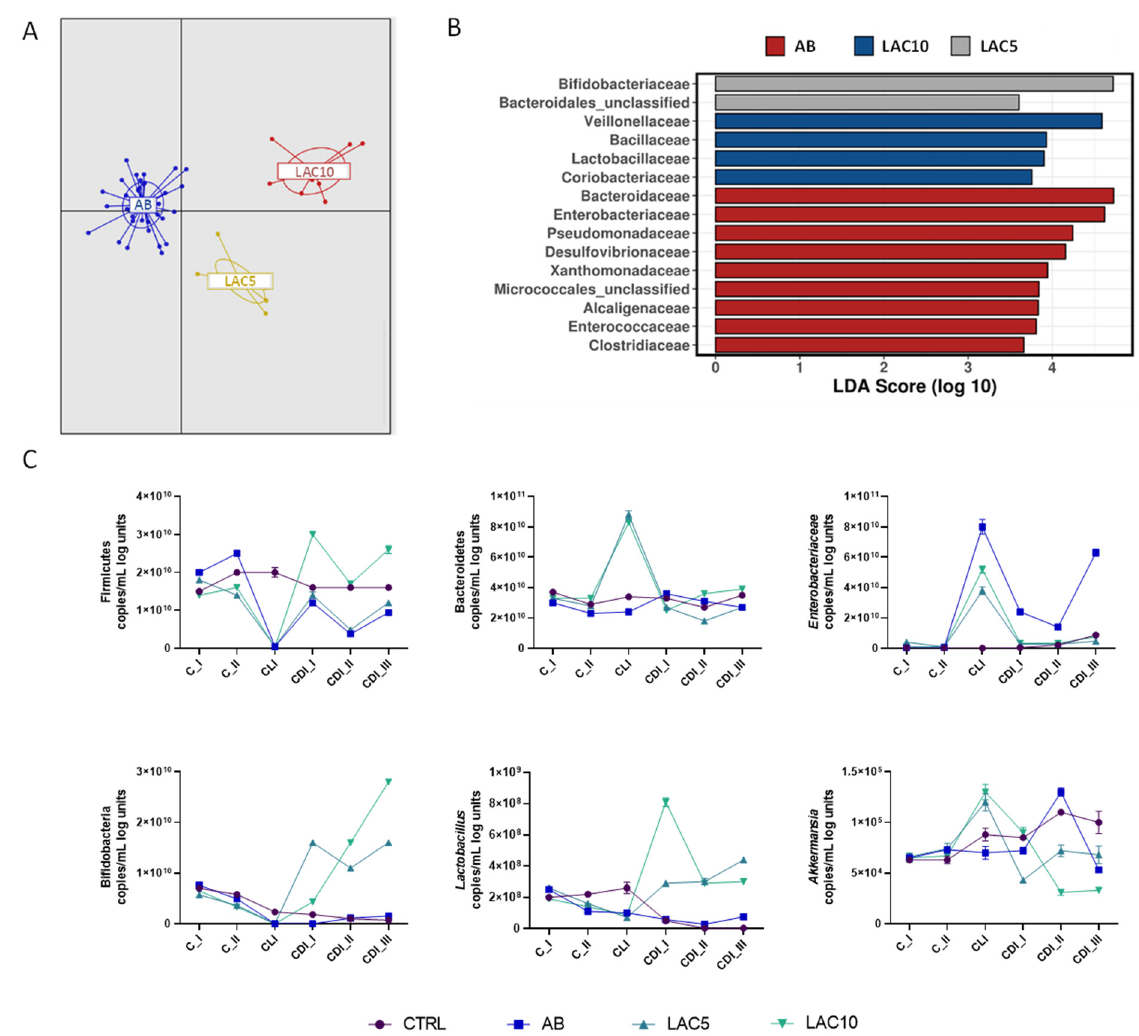
Figure 5. Effect of lactulose on clindamycin and C. difficile -induced dysbiosis in the proximal colon of the PathoGut TM SHIME model. ( A ) Discriminant Analysis of Principal Components (DAPC) for three of the experimental arms of the PathoGut™ SHIME experiment, including arm 2 (AB), arm 3 (LAC5) and arm 4 (LAC10). ( B ) Linear discriminant analysis Effect Size (LEfSe) at family level for three of the experimental arms of the PathoGut™ SHIME experiment, including arm 2 (AB), arm 3 (LAC5) and arm 4 (LAC10). ( C ) qPCR counts (copies/mL log units) of Firmicutes, Bacteroidetes, Enterobacteriaceae , lactobacilli, bifidobacteria and Akkermansia muciniphila during the course of the control period (C_I-II), the clindamycin treatment period (CLI) and the CDI stabilization period (CDI_I-III) of the PathoGut™ SHIME experiment for four of the experimental arms, including arm 1 (CTRL), arm 2 (AB), arm 3 (LAC5) and arm 4 (LAC10). Dots represent mean ± SEM of technical replicas of qPCR of one time point per period. Two-way ANOVA was used to calculate statistically significant differences between the experimental test arms, with significance highlighted in the text ( p < 0.05). 2.8. Effect of Lactulose on Gut Dysbiosis Induced by Vancomycin and C. difficile Overall, both lactulose supplementation dosages (LAC5V0, LAC10V0, LAC5V1 and LAC10V1 arms) had a significant effect on the gut microbial community, compared to vancomycin alone (AB arm) ( p < 0.001, Adonis test based on Bray–Curtis distance, Figure 6A). AB reactors encounted high numbers of Enterobacteriacea , Desulfovibrionaceae , Sutter- ellaceae , Clostridiaceae , Microbacteriaceae and Xanthomonadaceae (Figure 6B), whereas LAC5V1 induced an enrichment of Lachnospiraceae , Tannerellaceae and Alcaligenaceae (Fig- ure 6B).